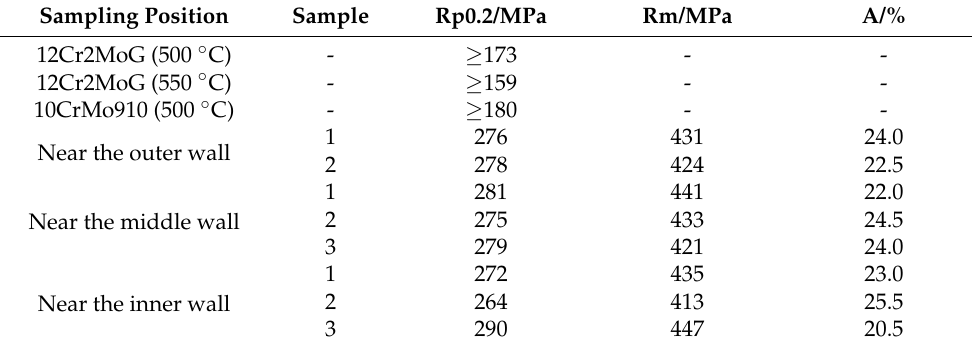
Table 6. The tensile test results at 580 ◦